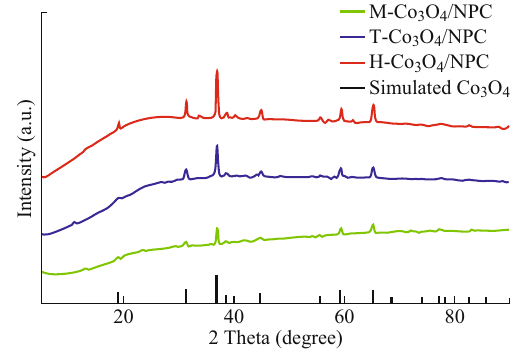
Fig. 4 PXRD patterns of T-Co 3 O 4 /NPC, M-Co 3 O 4 /NPC, and H-Co 3 O 4 /NPC composites The thermal stabilities of the three composites were investigated by TGA under air atmosphere. As shown in Fig. 6, heavy mass losses for M-ZIF-67, H-ZIF-67, and T-ZIF-67 started at 550, 300, and 400 (cid:3) C, respectively. When the temperature increased to 950 (cid:3) C, the weights remained at 44.85%, 11.17%, and 36.96%, respectively. The dramatic weight loss was attributed to the combustion of the carbon species. It is noteworthy that both H-ZIF-67 and